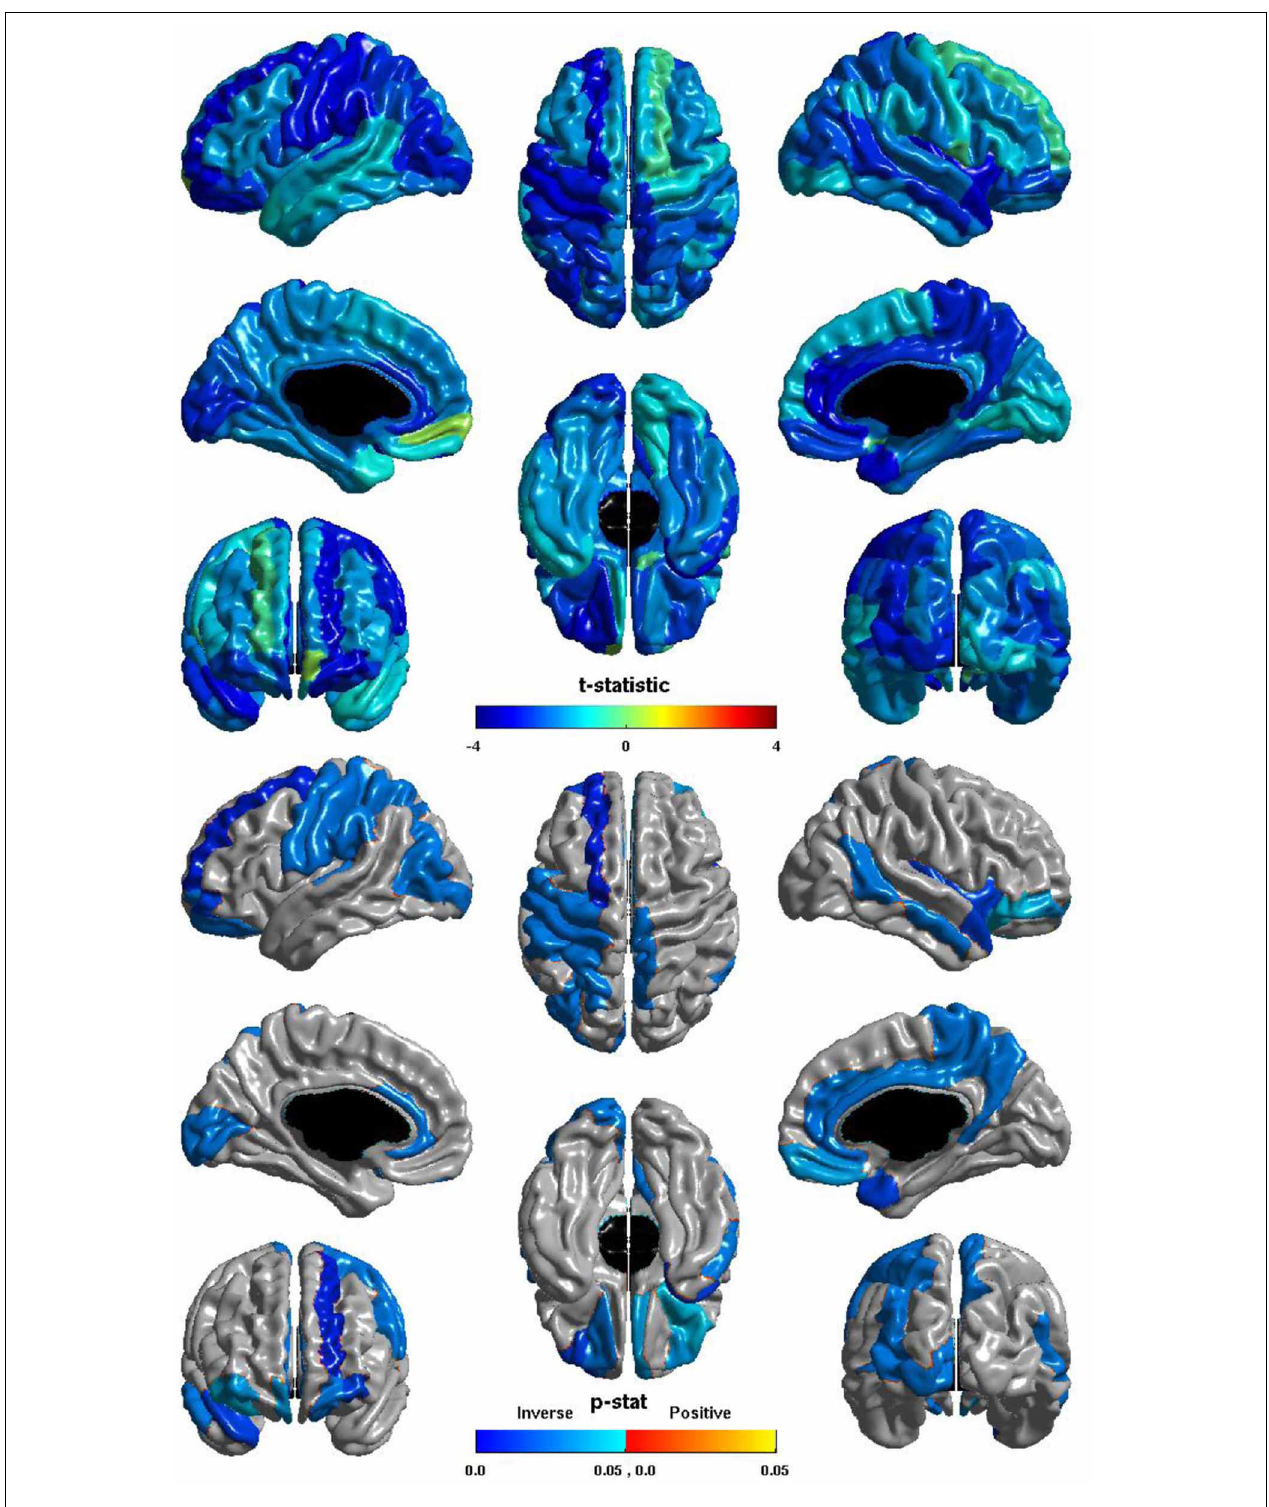
FIGURE 4 | Nodal Global Efficiency and ICV. The t -statistic (top) and the p -statistic (bottom) for the relation between ICV and nodal global efficiency in each region of the AAL atlas. A negative t -statistic represents decreasing nodal global efficiency with increasing ICV. The t -statistic is predominately negative. The p -statistic is FDR-corrected, and is blue where the inverse